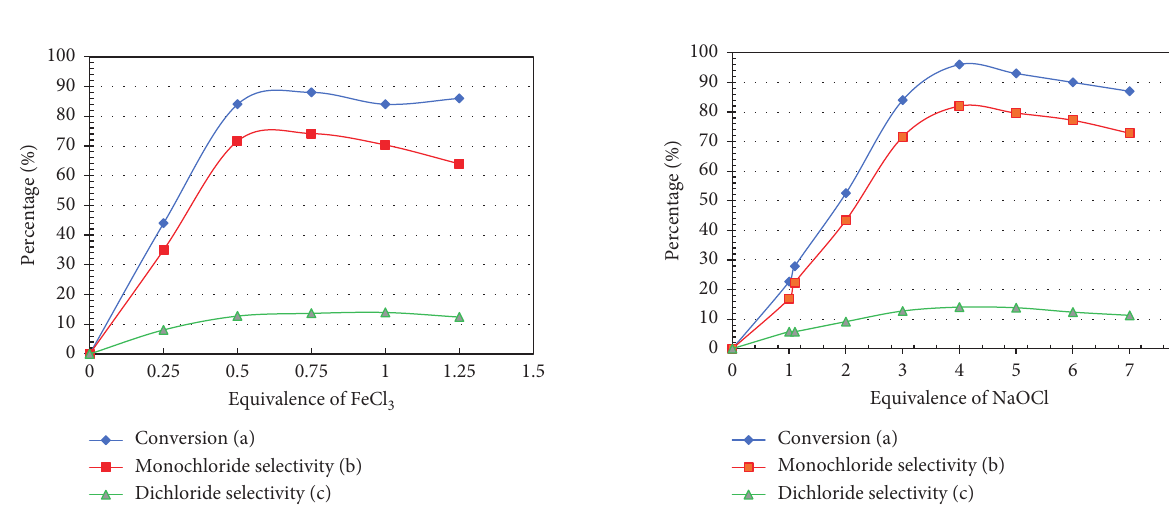
Figure 2: Effect of NaOCl